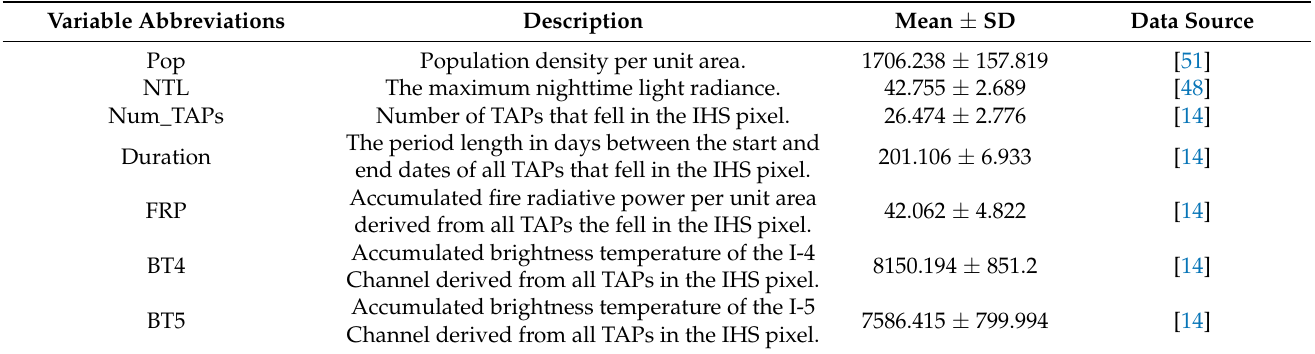
Table 1. Summary statistics and descriptions of explanatory variables for the carbon emission